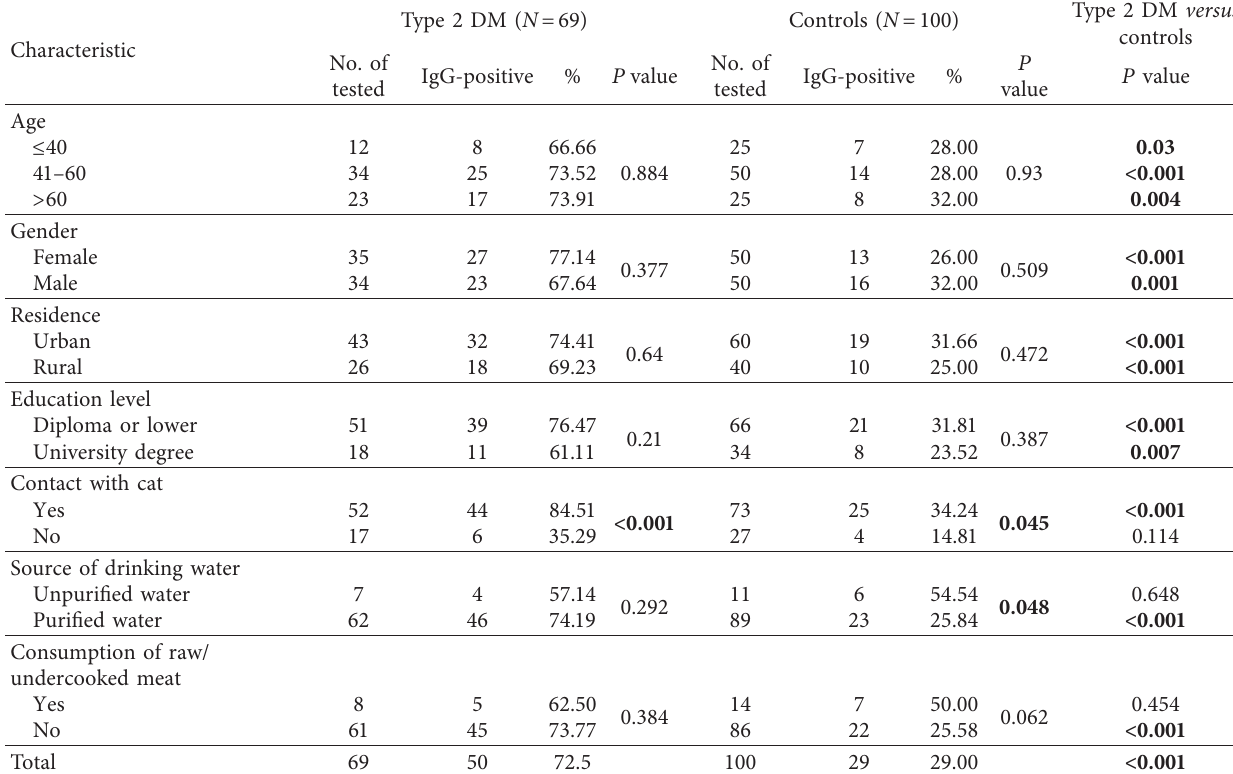
Table 2: Demographic characteristics and risk factors related to the seroprevalence of T. gondii infection in T2DM patients, Khorramshahr